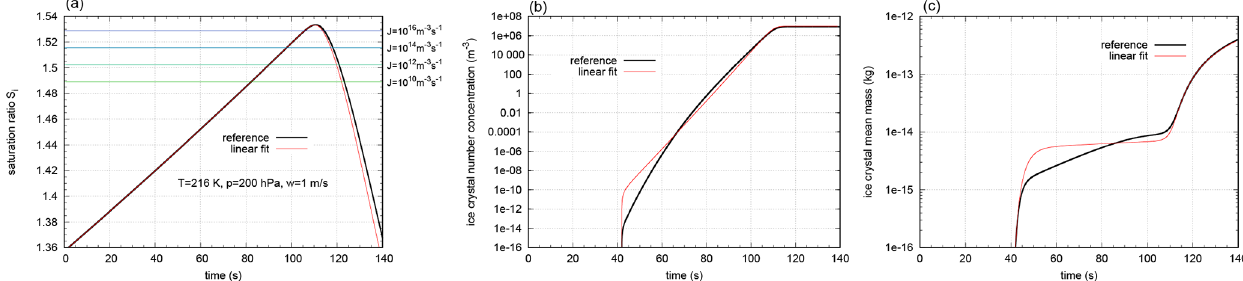
Figure B2. Representative example for a typical nucleation event for temperature T = 216K and pressure p = 200hPa with a forcing of w = 1ms − 1 . Red line – reference nucleation rate after Koop et al. (2000) and black line – nucleation rate approximated by linear function as given in Eq. (38). (a) Saturation ratio, (b) ice crystal number concentration, and (c) mean mass.